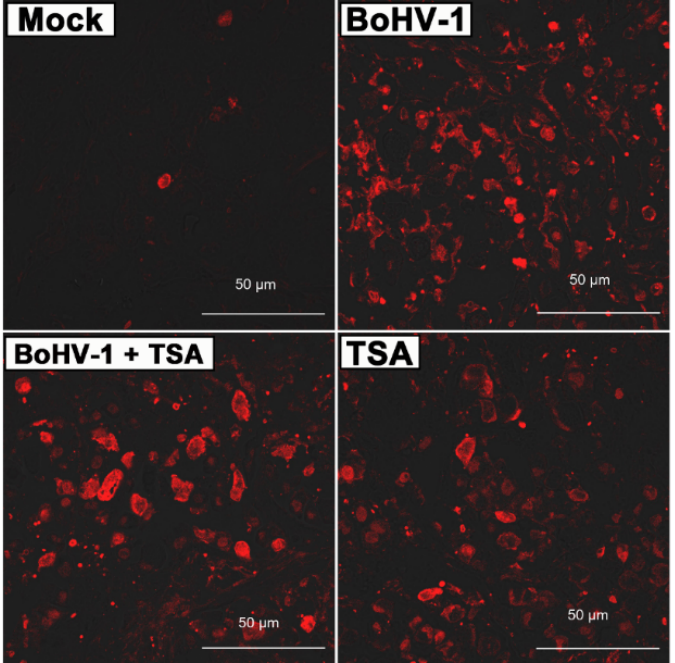
Figure 7. Of died cells in tumor sections. Tumor sections from PBS mock treated, BoHV-1, TSA, as well as BoHV-1 and TSA treated mice were processed for TUNEL assay. Images shown were represents of one mouse in each group.